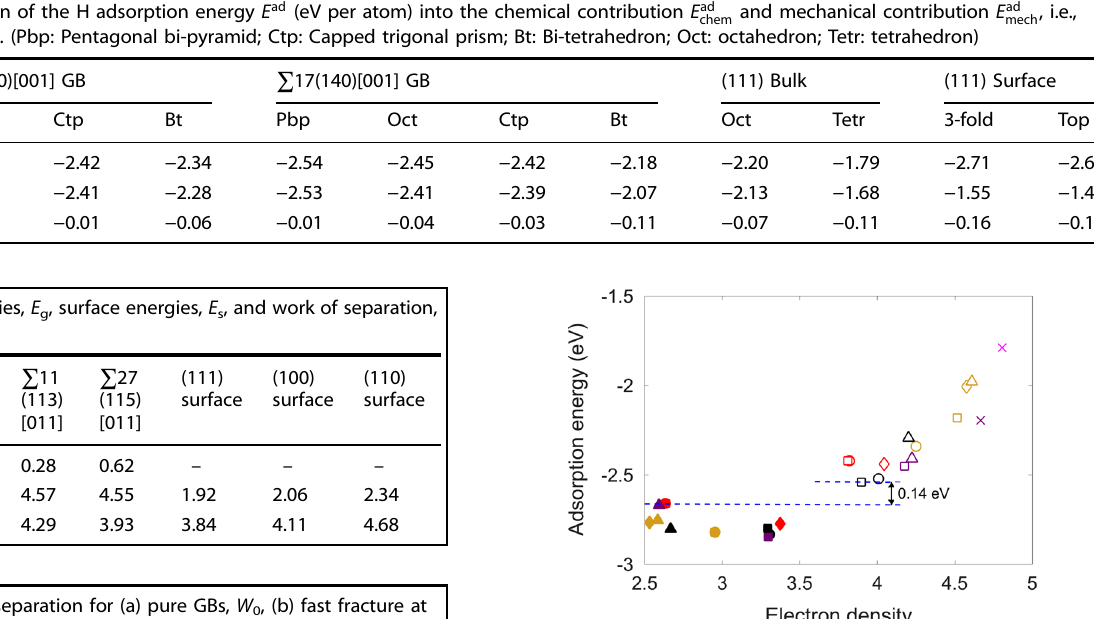
Table 3. Separation of the H adsorption energy E ad (eV per atom) into the chemical contribution E ad